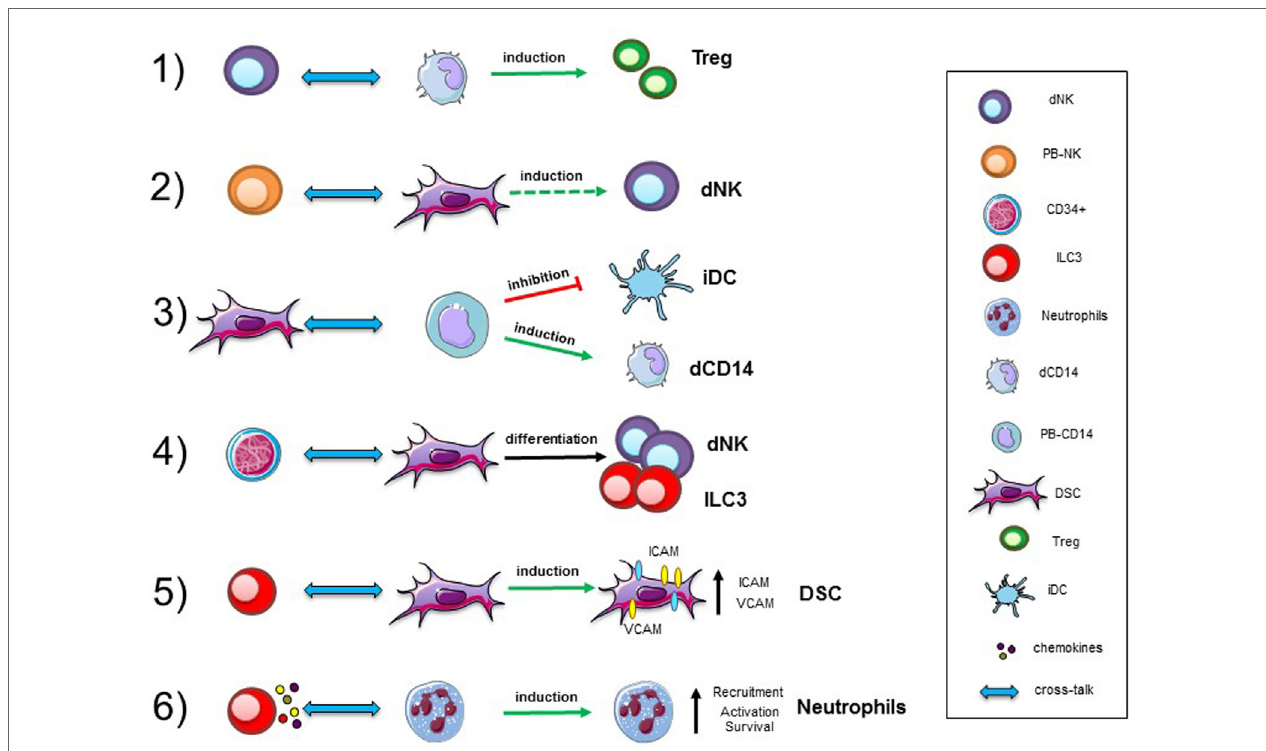
FiGURe 1 | Cellular interactions in human decidua. Representative interactions between immune cells, precursors, and stromal cells occurring in decidual tissues during the first trimester of pregnancy. Abbreviations: dNK, decidual natural killer cells; PB-NK, peripheral blood NK cells; ILC, innate lymphoid cells; dCD14, decidual myeloid cells; PB-CD14, peripheral blood myeloid cells; DSC, decidual stromal cells; Treg, regulatory T cells; iDC, immature dendritic